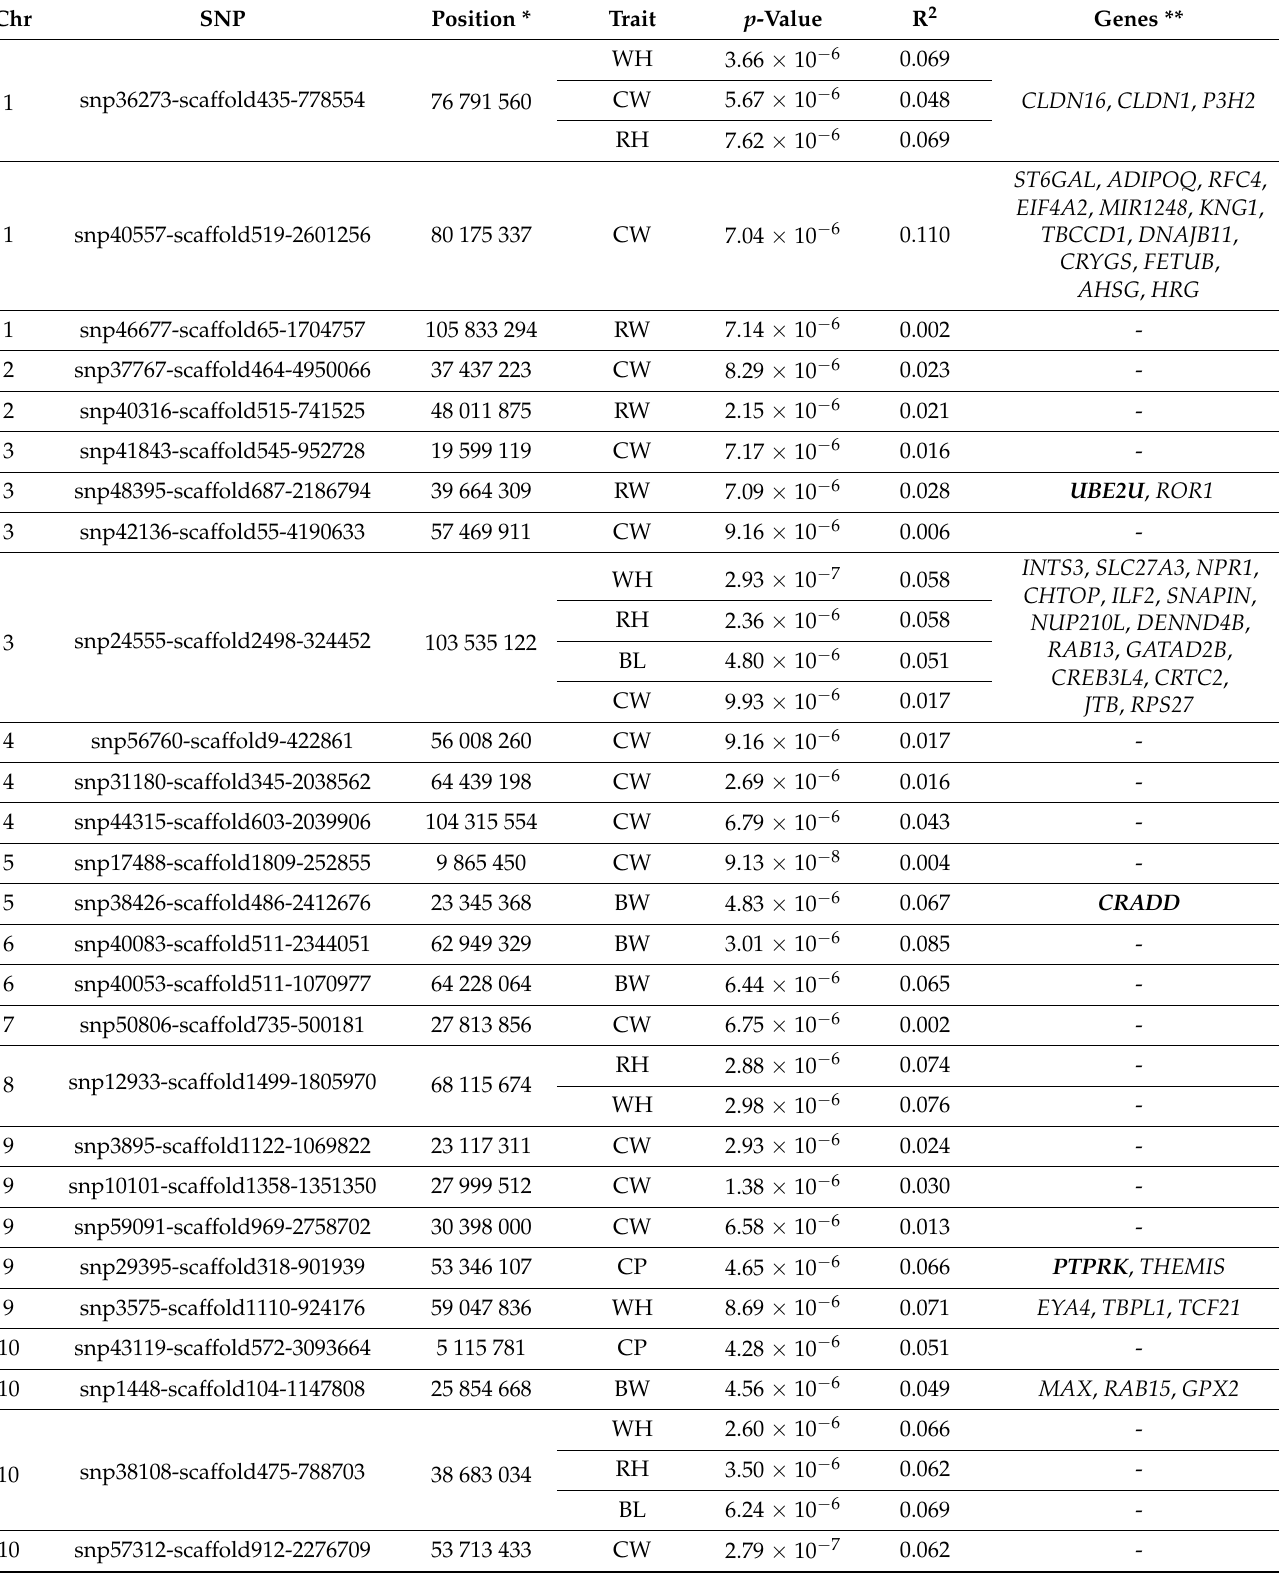
Table 3. Closest candidate genes for genome-wide SNPs ( p < 10 − 5 ) associated with body weight and body conformation traits based on GWAS in Karachai goats at age 8